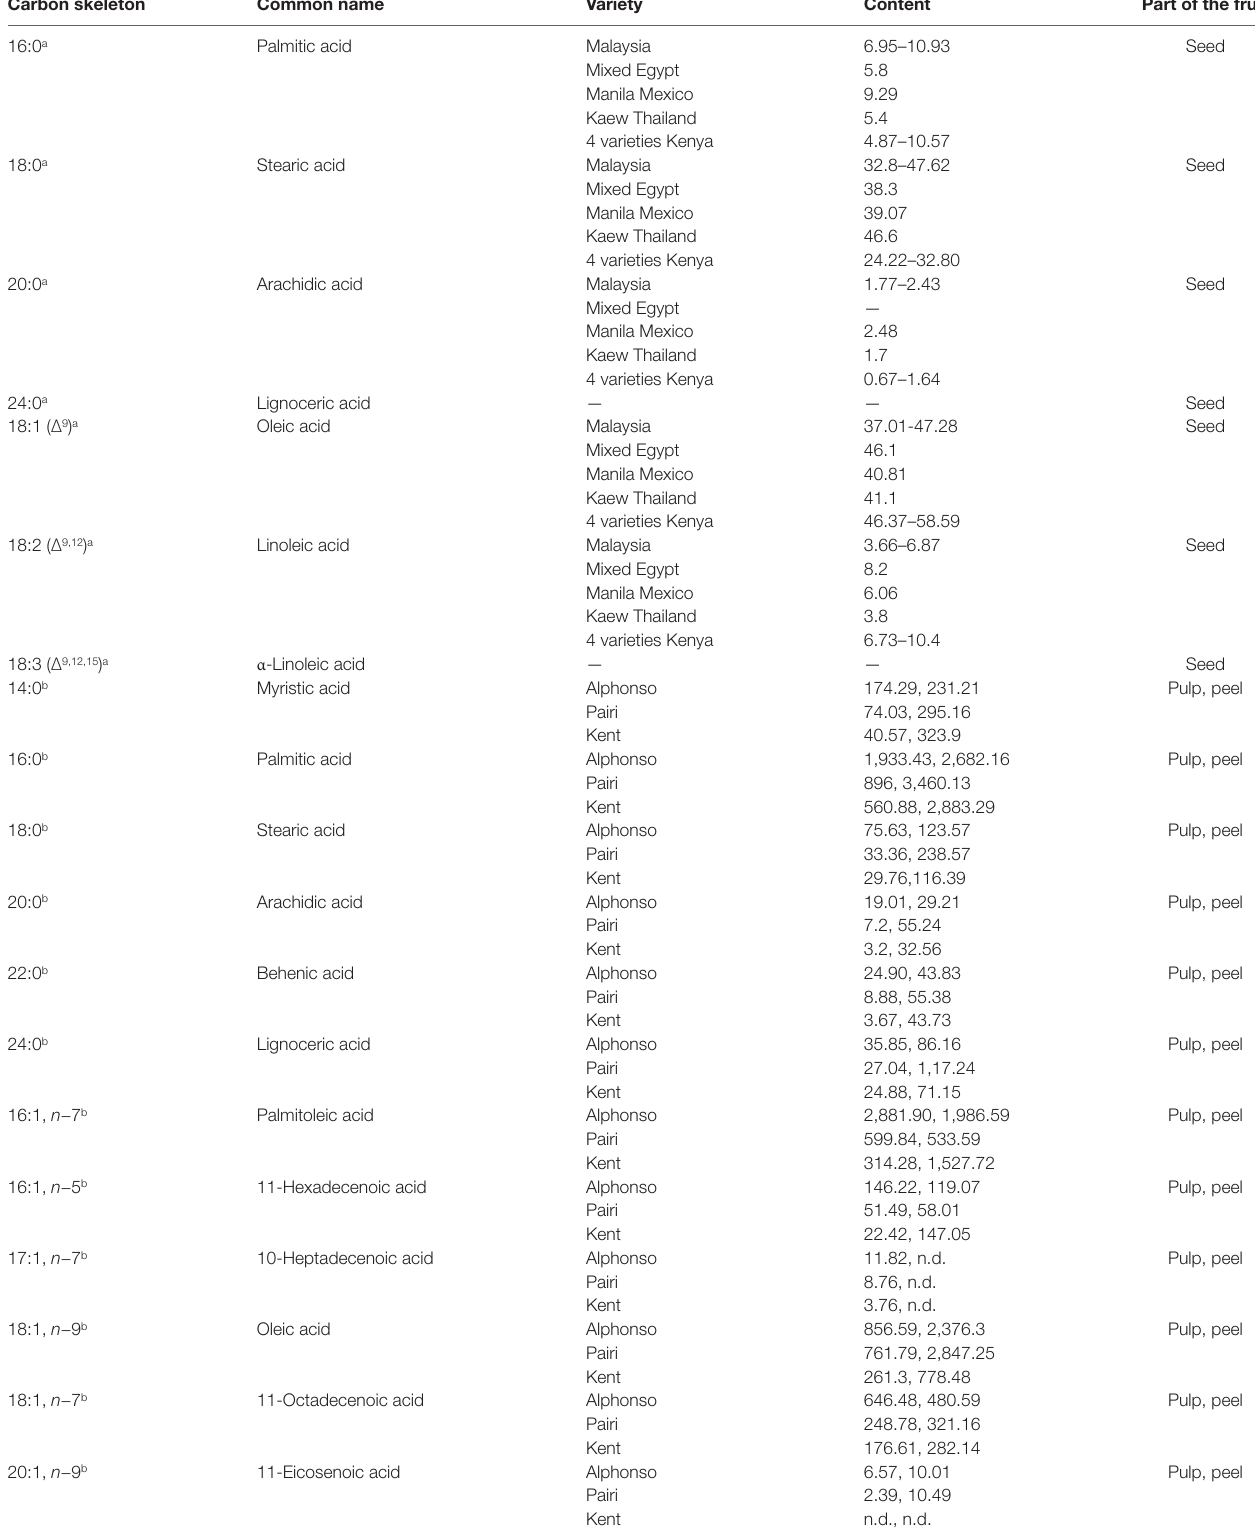
TABLE 3 | Content of fatty acids in mango